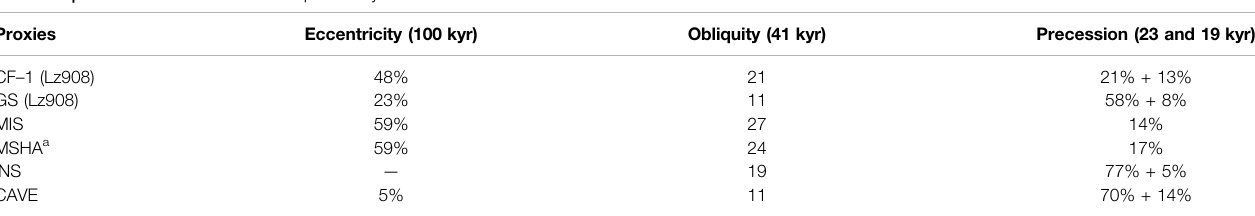
TABLE 1 | Relative ratios of each orbital periodicity in various